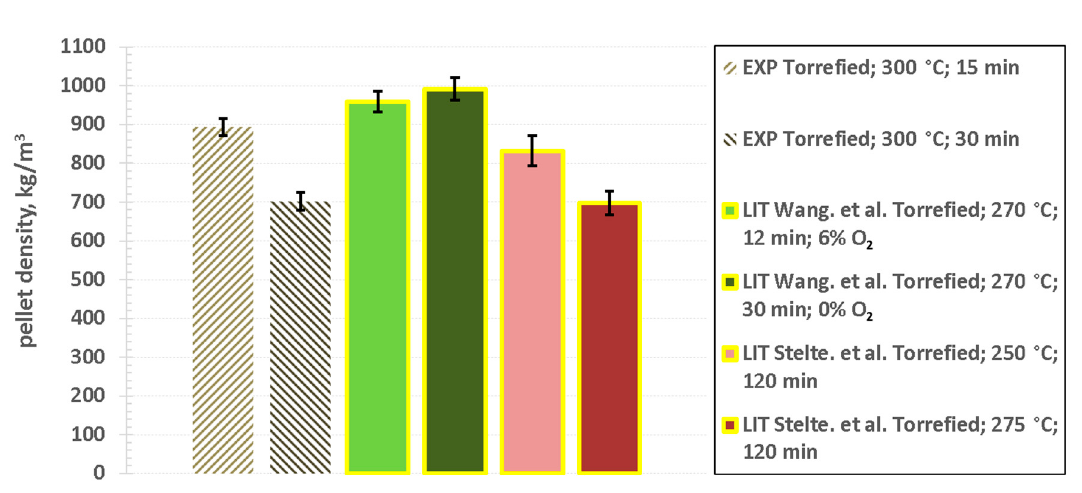
Figure 3. Rate of conversion – comparison of model and experiment for pyrolysis of pellets of raw and torrefied wood at 600 ° C: ( a ) raw wood pellet; ( b ) pellet of fine wood particles torrefied at 300 °C for 5 min; ( c ) pellet of fine wood particles torrefied at 300 °C for 30 min.